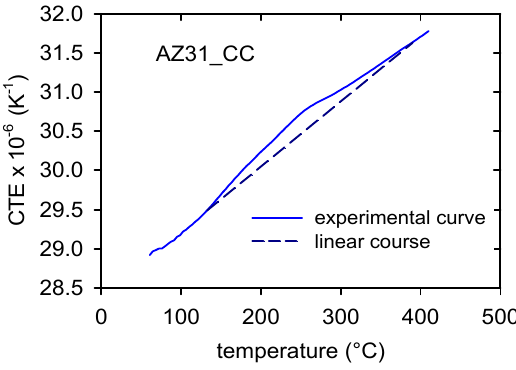
Figure 13. Temperature dependence of the thermal expansion coefficient.